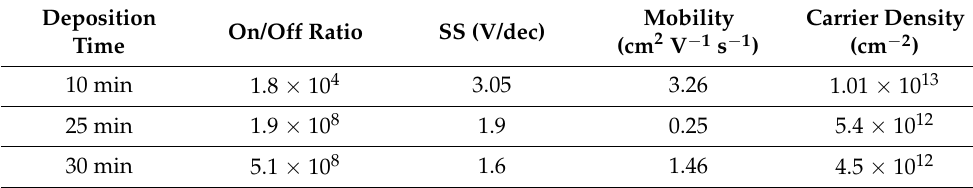
Table 1. Electrical properties of MoS 2 deposited at different growth times.